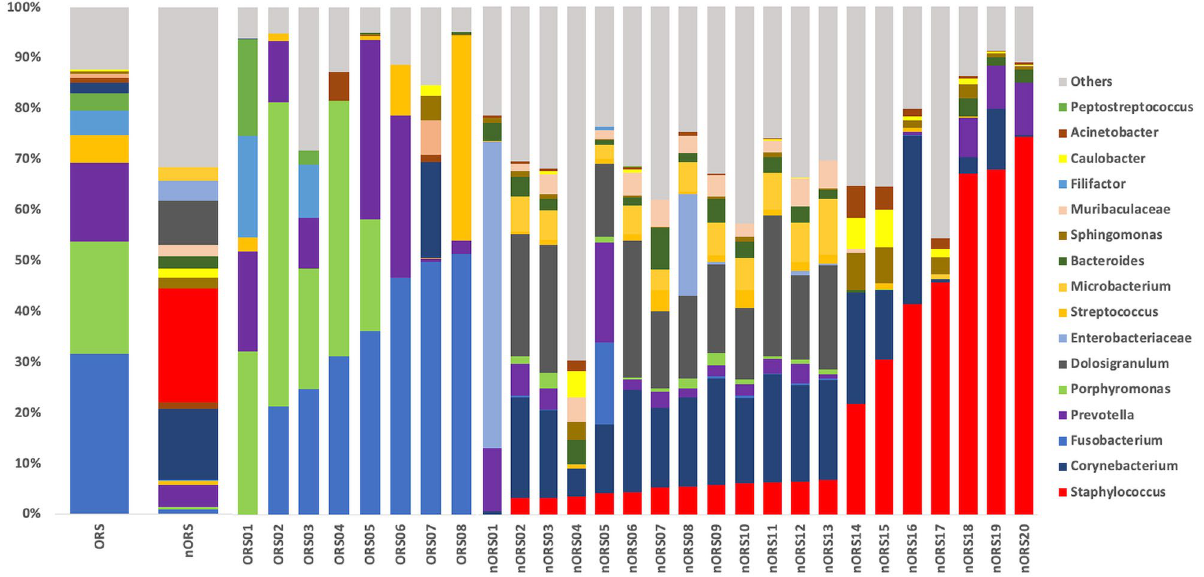
Figure 3. 16S rRNA gene-based bacterial community composition and abundance data for middle meatus samples collected from patients with odontogenic rhinosinusitis (ORS) and nonodontogenic rhinosinusitis (nORS). Taxa having less than 1% abundance were annotated as others.